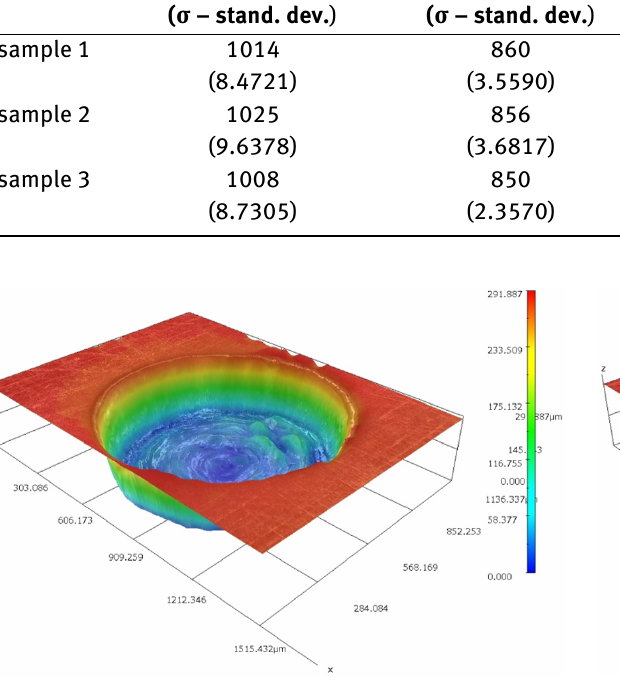
Figure 12: 3D profile of the third sample for trajectory No.